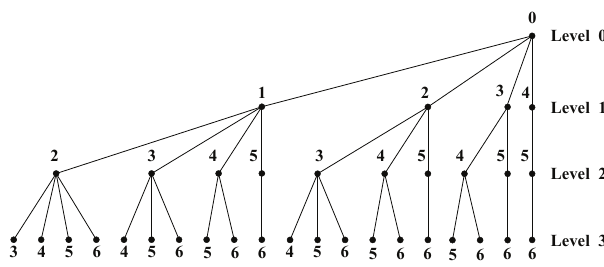
Figure 3. Illustration of the BBS-MS searching tree with N t = 8 and L = 3.